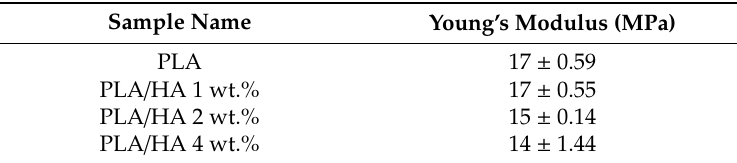
Figure 7. Mechanical tests of PLA and PLA / HA composite films. Table 2. Mechanical tests of obtained